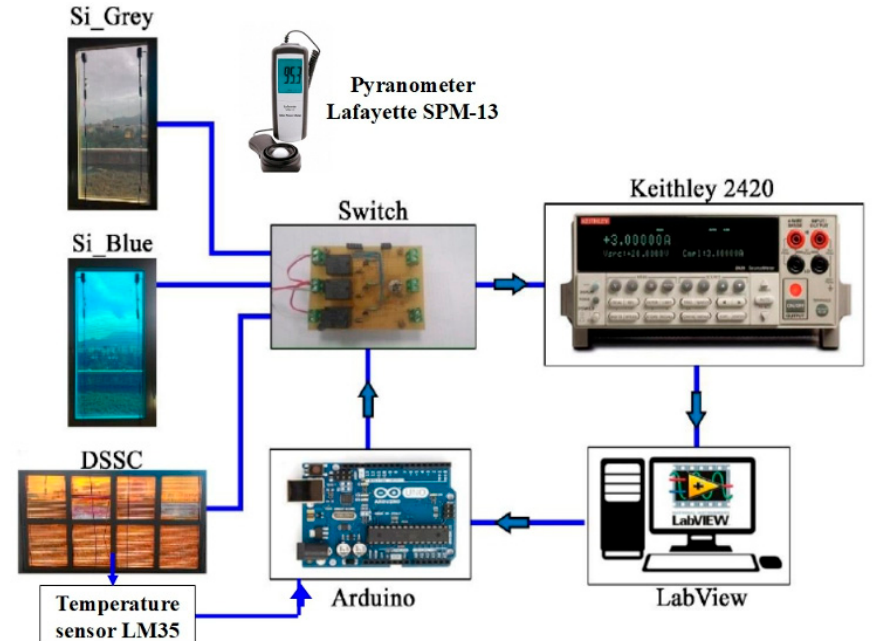
Figure 11. Test bench setup. Labview was used to acquire experimental data from Keythley 2420 (12 mV source voltage accuracy and 1.5 mA measurement current accuracy) and Arduino was used to switch the connection among the three source panels.